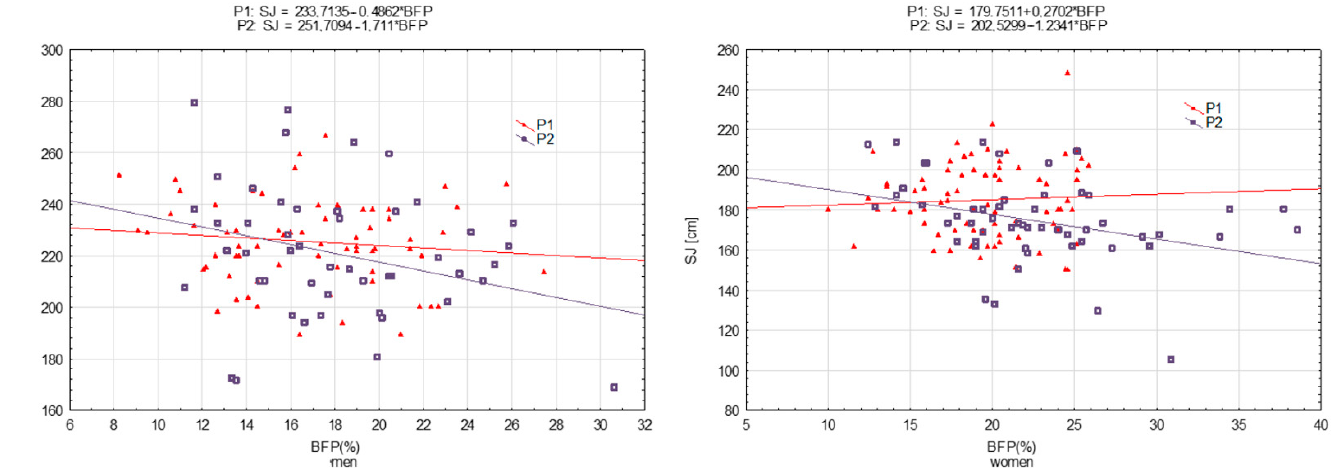
Figure 3. Power of legs (SJ) measured in 2001 (P 1 ) and 2022 (P 2 ) regressed on body fat percentage (BFP)—men and women, respectively.